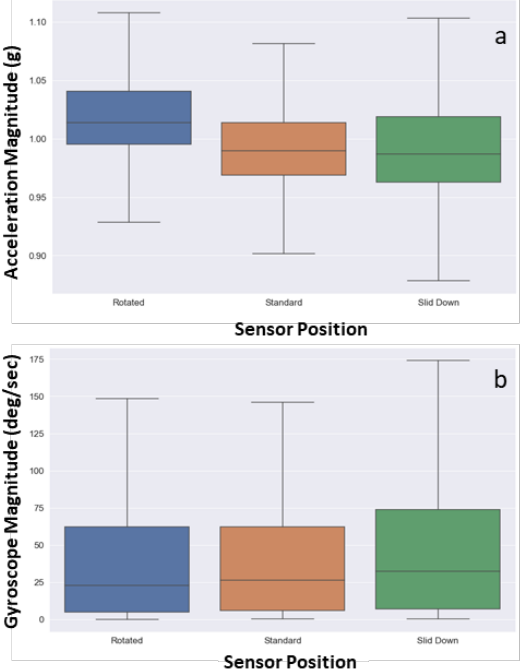
Figure 7 . Comparison of ( a ) acceleration and ( b ) gyroscope magnitude for three (rotated, standard, and slid) sensor positions.